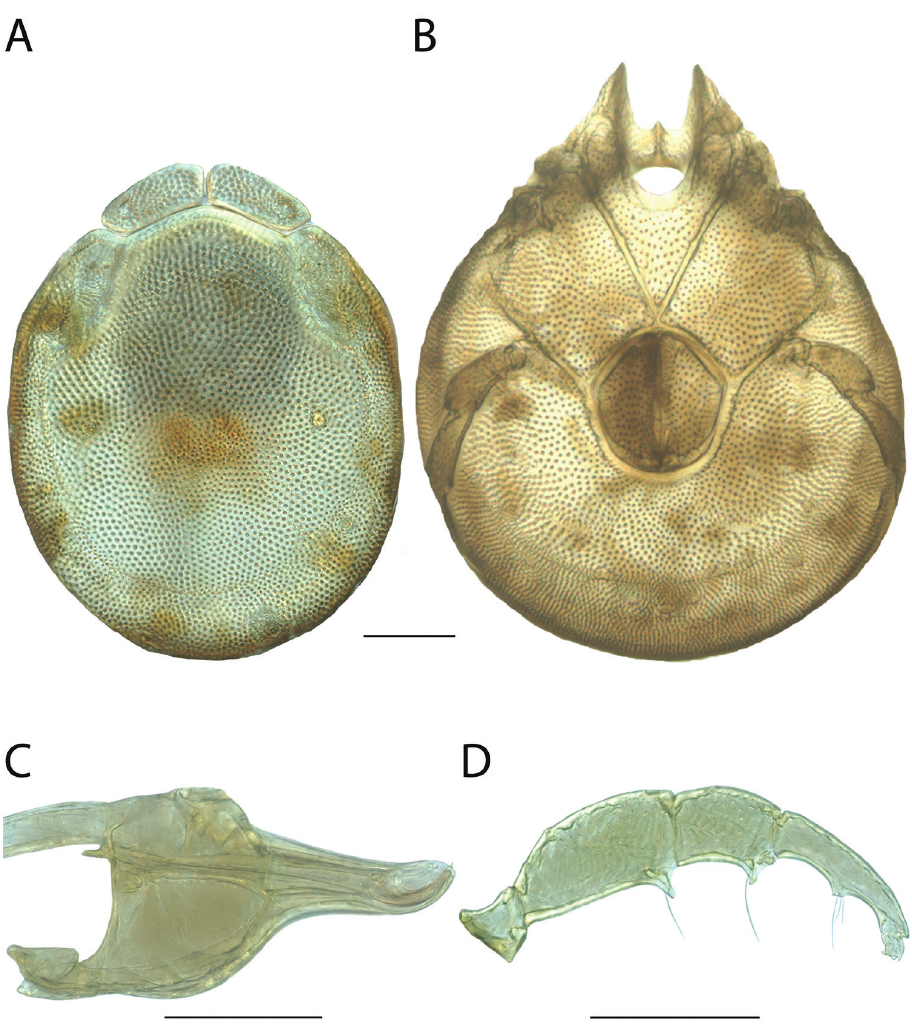
Figure 262. Torrenticola ululata sp. n. female: A dorsal plates B venter (legs removed) C subcapitulum D pedipalp (setae not accurately depicted). Scale = 100 µm.